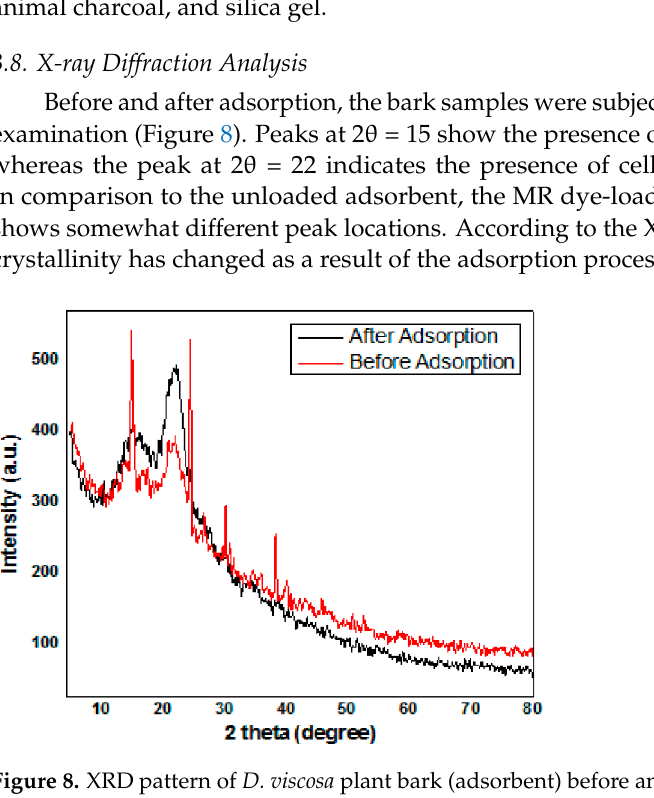
Figure 8. XRD pattern of D. viscosa plant bark (adsorbent) before and after adsorption of MR